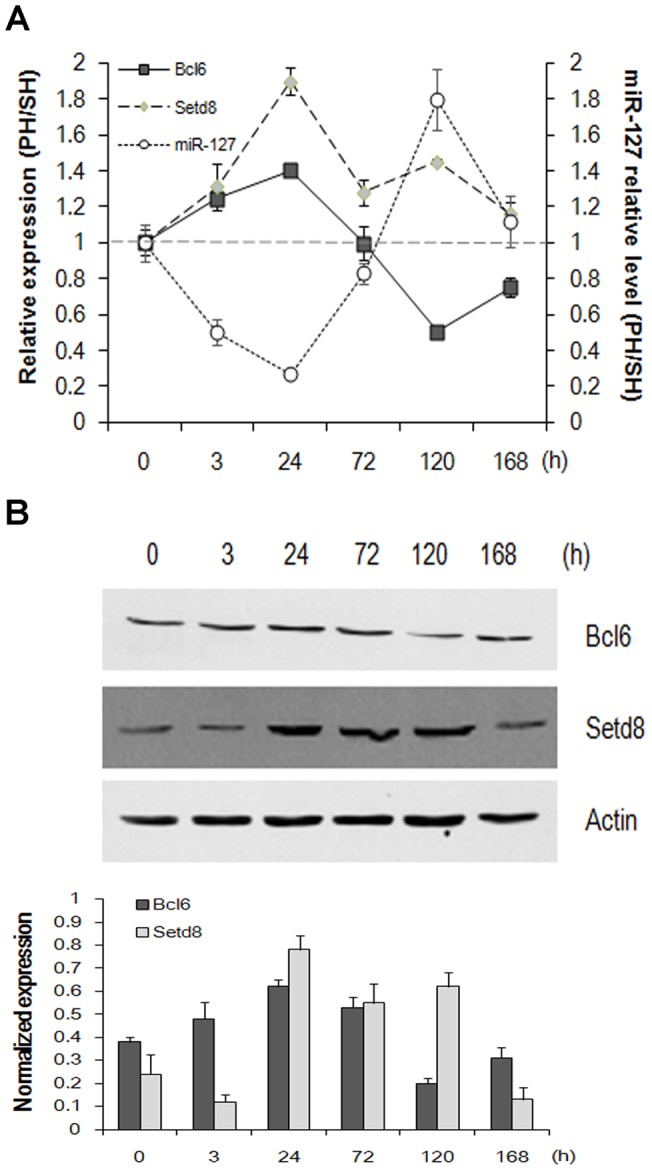
MiR-127 expression inversely correlates with the expression of Bcl6 and Setd8 during liver regeneration.(A) The mRNA expression of Bcl6 and Setd8 were analyzed by qRT-PCR. β-actin was used as the internal control. Data from three independent experiments are shown as the means ± SD. (B) The protein expression of Bcl6 and Setd8 were analyzed by Western blotting. The quantification of bands of Bcl6 and Setd8 were performed by densitometry. Actin was used as a control. Representative data from one of three independent experiments are shown.